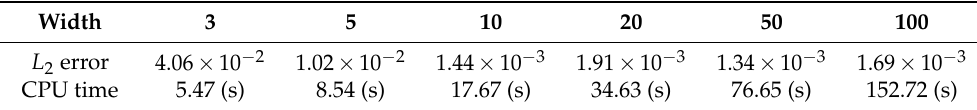
Table 2. Example 1: L 2 error and CPU time using different widths under depth = 4, with 2000 training data points.